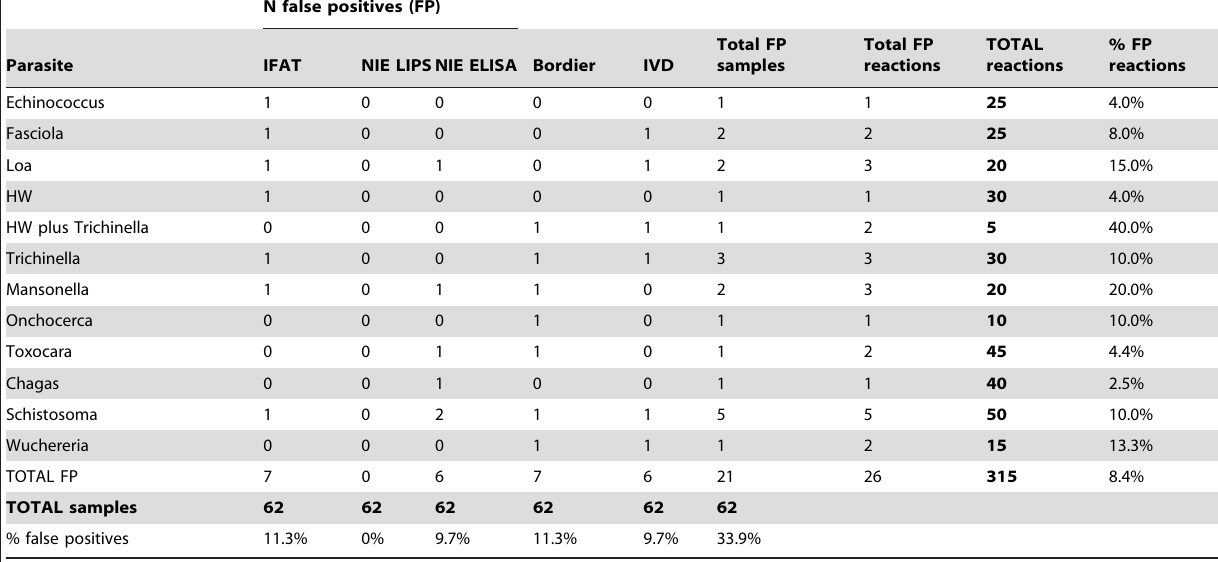
Table 5. Cross reactions with other parasites (Group III b: 62